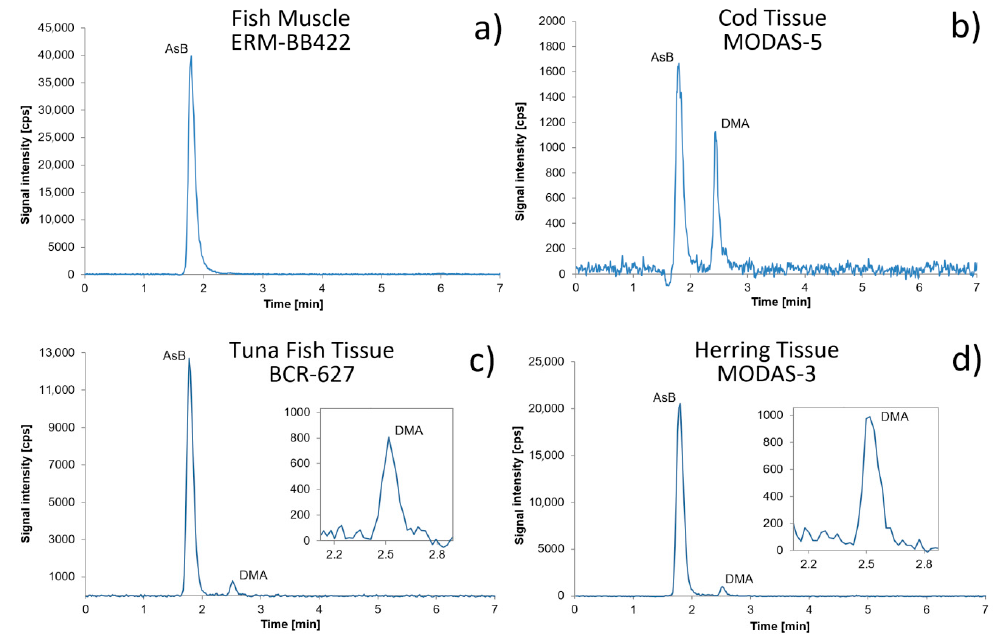
Figure 1. Chromatograms of ( a ) Fish Muscle ERM-BB422, ( b ) Cod Tissue MODAS-5, ( c ) Tuna Fish Tissue BCR 627, and ( d ) Herring Tissue MODAS-3.